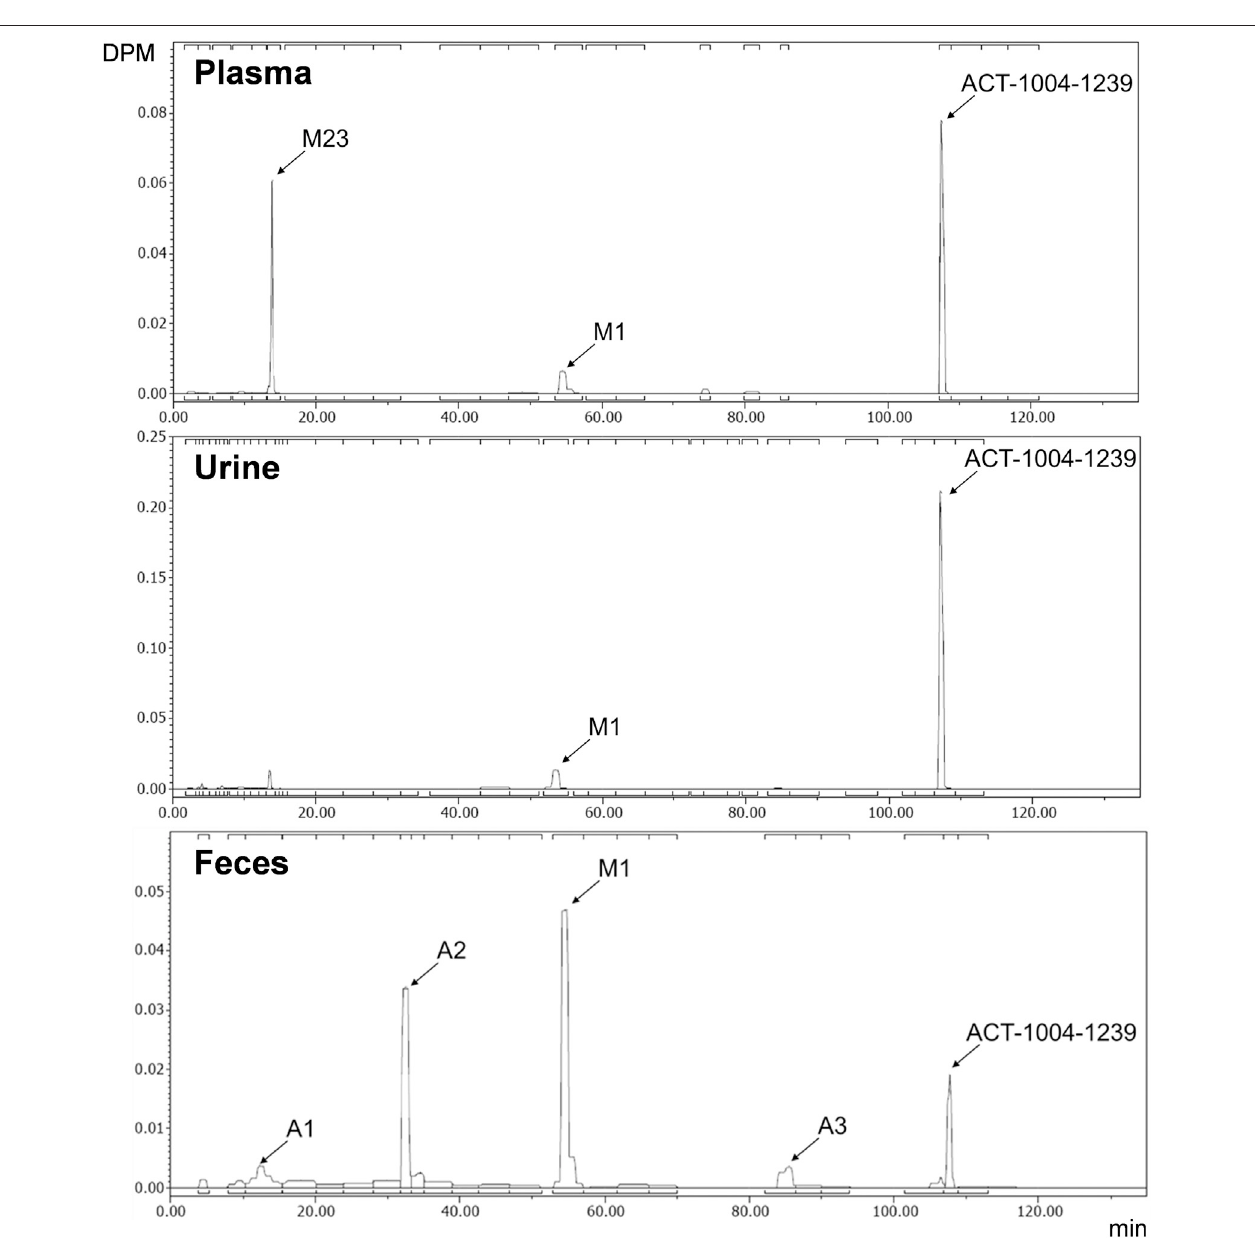
FIGURE4| Metabolicpro fi lesofACT-1004-1239inhumanplasma(top),urine(middle),andfeces(bottom)pools.Squaredbracketsplacedaboveandbeloweach radiochromatogram indicate metabolites with a relative abundance of < 5%.